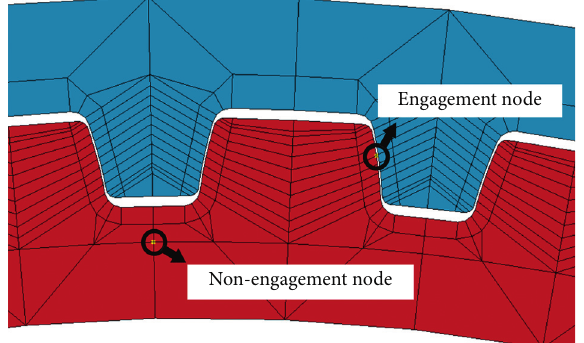
Figure 10: Typical contact node and noncontact node on axle